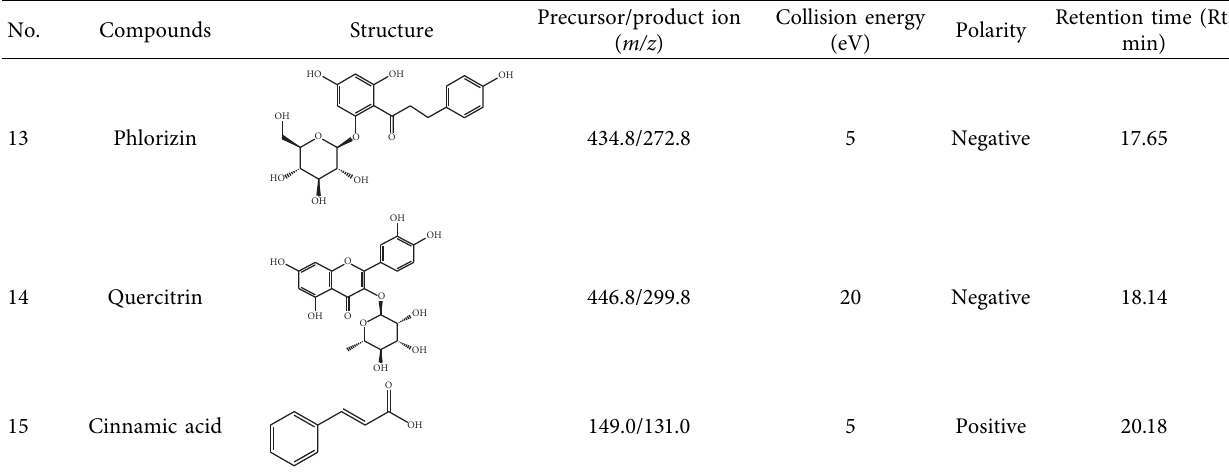
during subsequent separation. The effect of 4 levels of